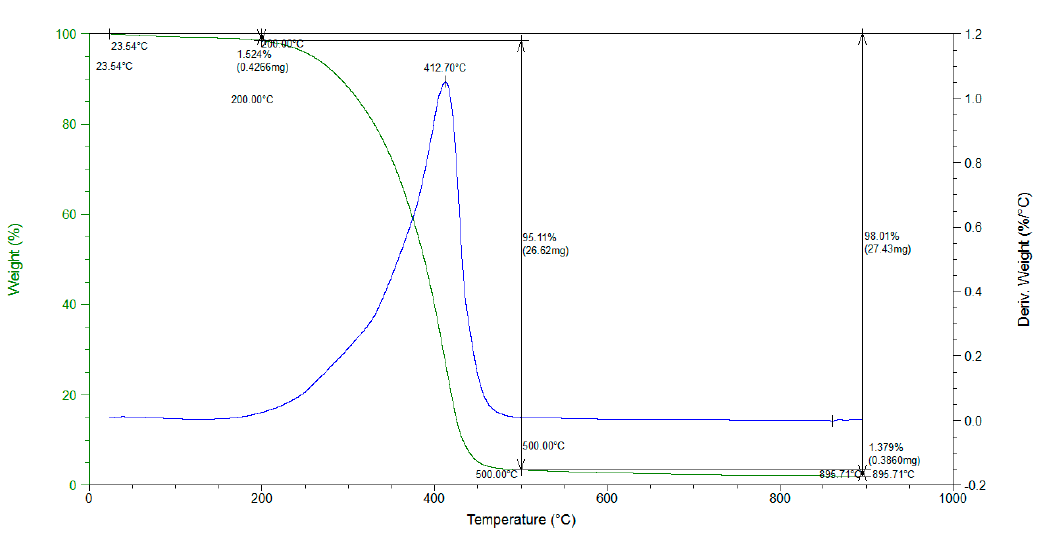
Figure 8. The GPC results of the product.